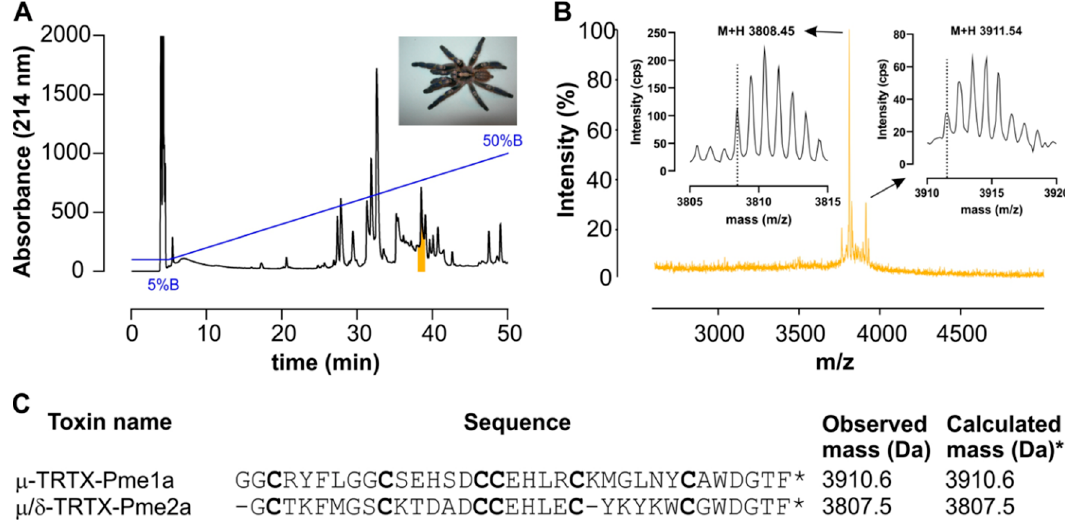
Figure 1. Isolation of novel spider peptides μ -TRTX-Pme1a and μ / δ -TRTX-Pme2a from the venom of P. metallica. ( A ) Chromatogram resulting from fractionation of the crude venom using RP-HPLC. Blue line indicates gradient of solvent B. Colour indicates the active peak that was further purified using activity guided fraction. ( B ) MALDI-TOF MS spectrum showing the M + H + ions for the dominant masses present in the active peak. (C) Sequences of μ -TRTX-Pme1a and δ -TRTX-Pme2a identified by N-terminal sequencing and their observed (uncharged) and calculated (uncharged) monoisotopic masses. The calculated mass was –1 Da due to the amidated C-terminus (as indicated by *).